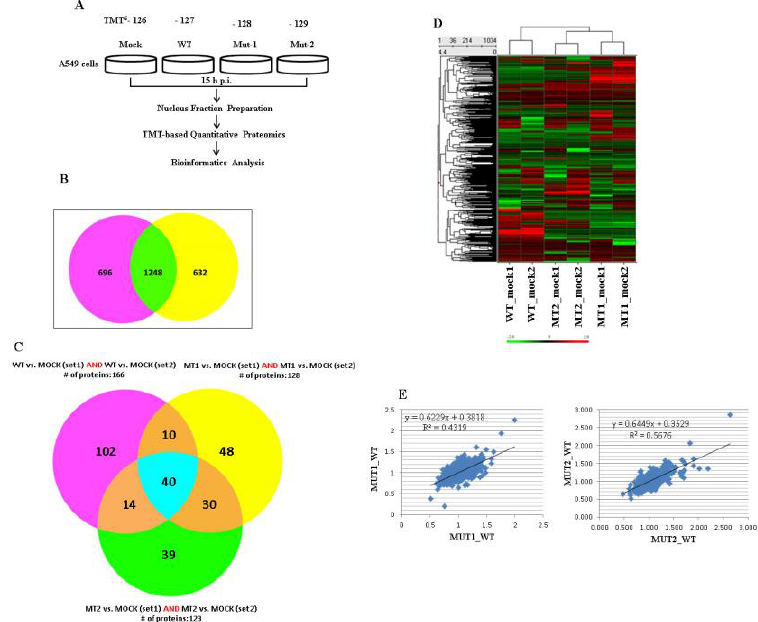
Figure 2. Nuclear protein expression changes with hMPV infection. ( A ) The overall workflow. A549 cells were mock infected or infected with viruses as indicated at a multiplicity of infection (MOI) of 2 for 15 h. Nuclear fractions were prepared and followed sequentially by protein quantification, reduction, precipitation, and digestion. The tandem mass tagging (TMT) isobaric mass tagging kit was then used to label the peptides followed by the fraction using a PicoFrit column. The treated samples were then subjected to LC-MS/MS analysis. Two technical sets of the samples were done at different times; ( B ) Number of detected nuclear proteins. There were 1944 and 1880 detected proteins in each experimental set. Among them, 1248 genes were identified to be common between the two sets; ( C ) Common proteins with expression fold change ≥ 1.2 with hMPV infection, WT, Mut-1 (MT1), or Mut-2 (MT2). There were 166 common proteins that changed with WT hMPV infections from two technical settings. In addition, 128 and 123 proteins were changed with Mut-1 and Mut-2 infections, respectively. Forty proteins were further identified to change with all three infections; ( D ) Overall nuclear protein changes in response to hMPV infection. hMPV-induced changes of nuclear proteins were obtained by comparing their abundance in infected cells to that of corresponding mock-infected samples. Heat map with hierarchical clustering was then performed for the proteins with fold changes above absolute 1 in three out of six infectious samples using complete linkage clustering method with z-score scaling; ( E ) Multivariate statistical analysis using the “R” program. The proteins, filtered as significant in response to hMPV infection at p -value ≤ 0.05 and with a fold change of 1.2 and above, compared to baseline (uninfected), were selected. The upregulated and downregulated changes by motifs, compared to WT infection, were